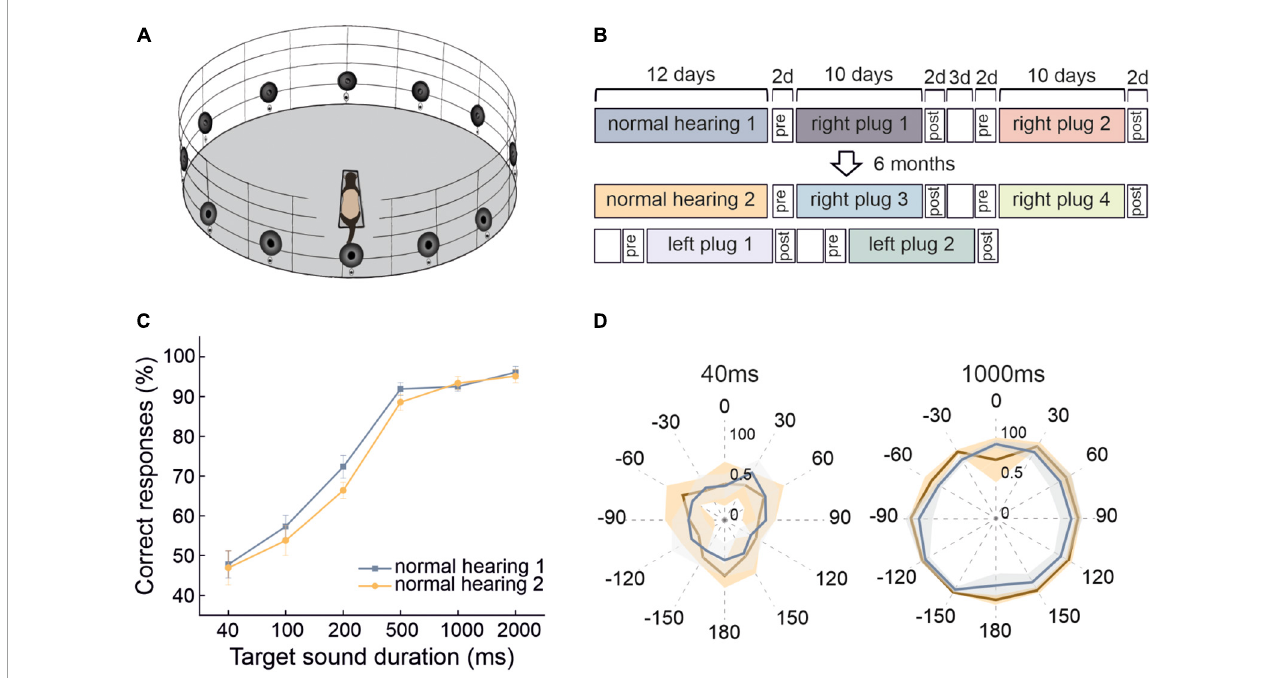
FIGURE1 Stability of ferret sound localization performance over time when normal spatial cues are available. (A) Schematic of the circular testing arena with 12 loudspeakers and reward ports located at 30 ◦ intervals around the perimeter and a central platform on which the animal stands facing position 0 ◦ in order to trigger each stimulus presentation. (B) Timeline of behavioral testing to explore the persistence of adaptive learning over multiple periods of monaural occlusion interspersed by periods of normal binaural hearing. These animals were first trained to adapt with the right ear plugged and then with the left ear plugged. (C) Localization performance (percentage of correct trials averaged across all 12 target locations and sound levels) at different sound durations for two normal hearing periods that were separated by extensive localization training with one ear occluded. Error bars show the standard error of the mean. (D) Spatial distribution of the percentage correct scores from both normal hearing periods for the 40- and 1,000-ms broadband noise bursts. Lines represent the means and shaded areas the standard error of these scores across animals.